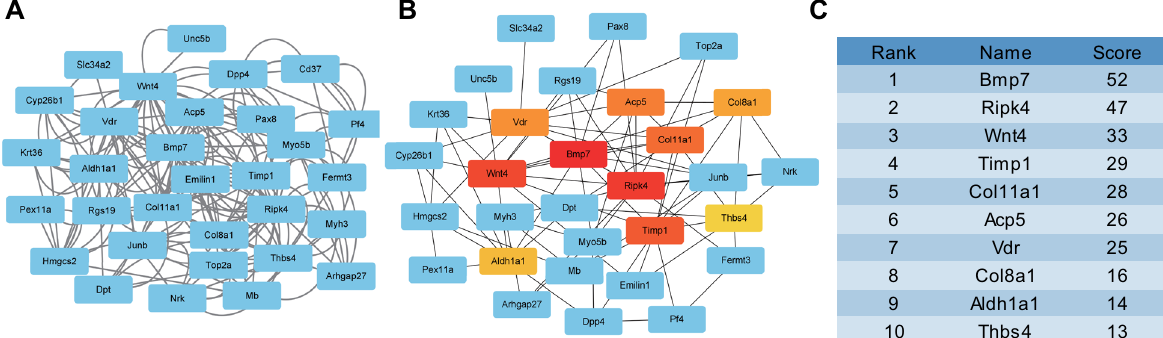
Fig. 5 PPI protein interaction analysis for key genes involved in IDD induced by T1DM. A PPI network for candidate gene analysis in STRING database. B PPI network for the top 10 core genes constructed using Cytoscape. Color from dark to light indicates the gene expression from low to high, and red indicates the highest expression. C The score of the top 10 core genes analyzed by